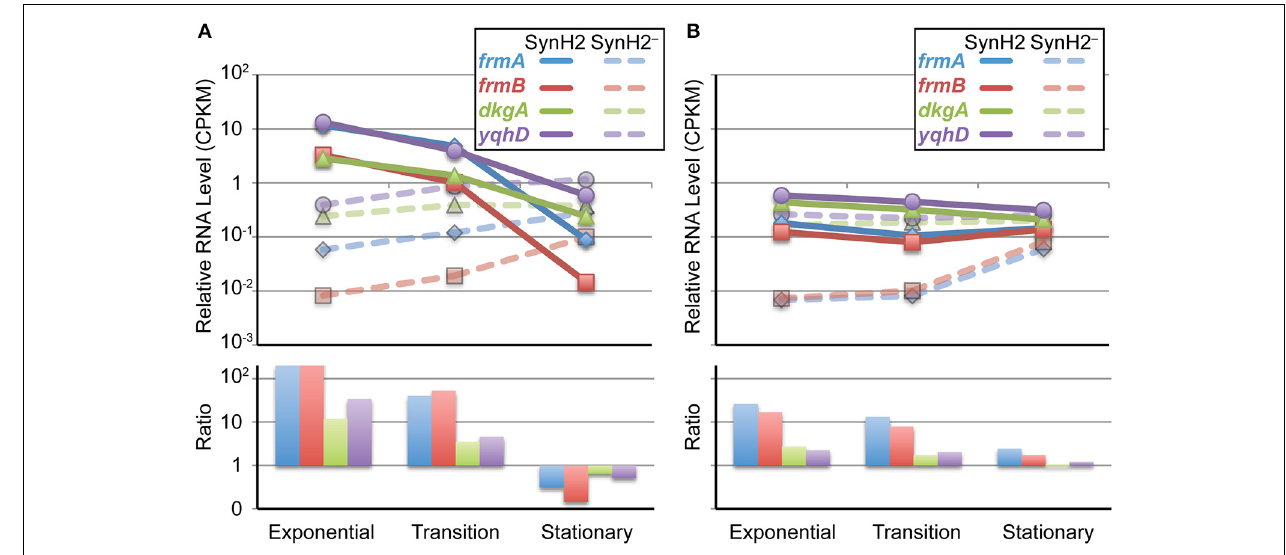
FIGURE 5 | Growth phase-dependent changes in inhibitor-responsive gene expression. Changes in RNA levels for genes that comprise the major regulatory response to aromatic inhibitors in SynH2. Shown are normalized RNA-seq measurements (top panel) from GLBRCE1 grown in SynH2 (solid